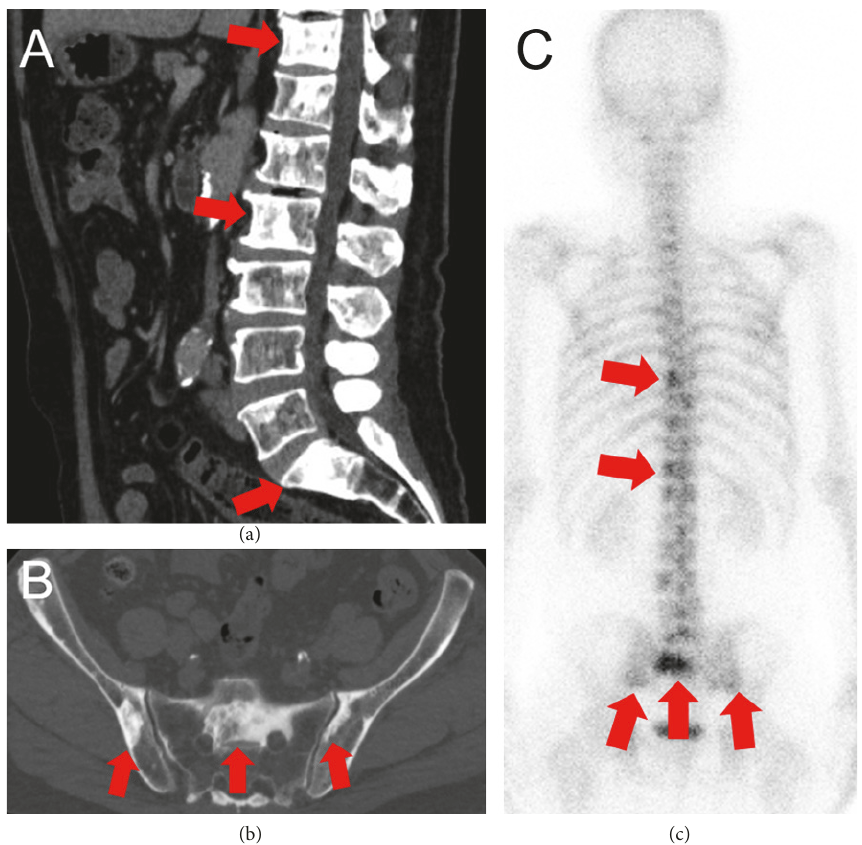
Figure 2: Imaging findings at the time of CRPC diagnosis. CT showed multiple osteoblastic lesions in the spine (a) and pelvic bone (b). Bone scan confirmed multiple accumulations at the same bone sites as CT (c). CRPC, castration-resistant prostate cancer; CT, computed